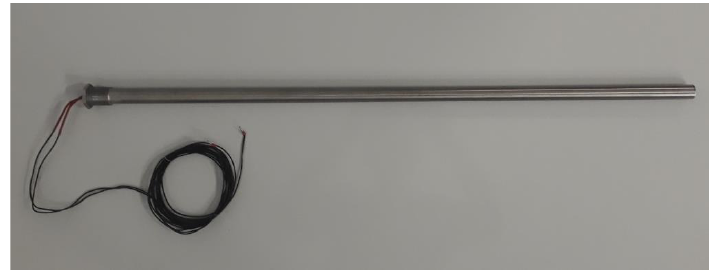
Figure 3. Patron heater.